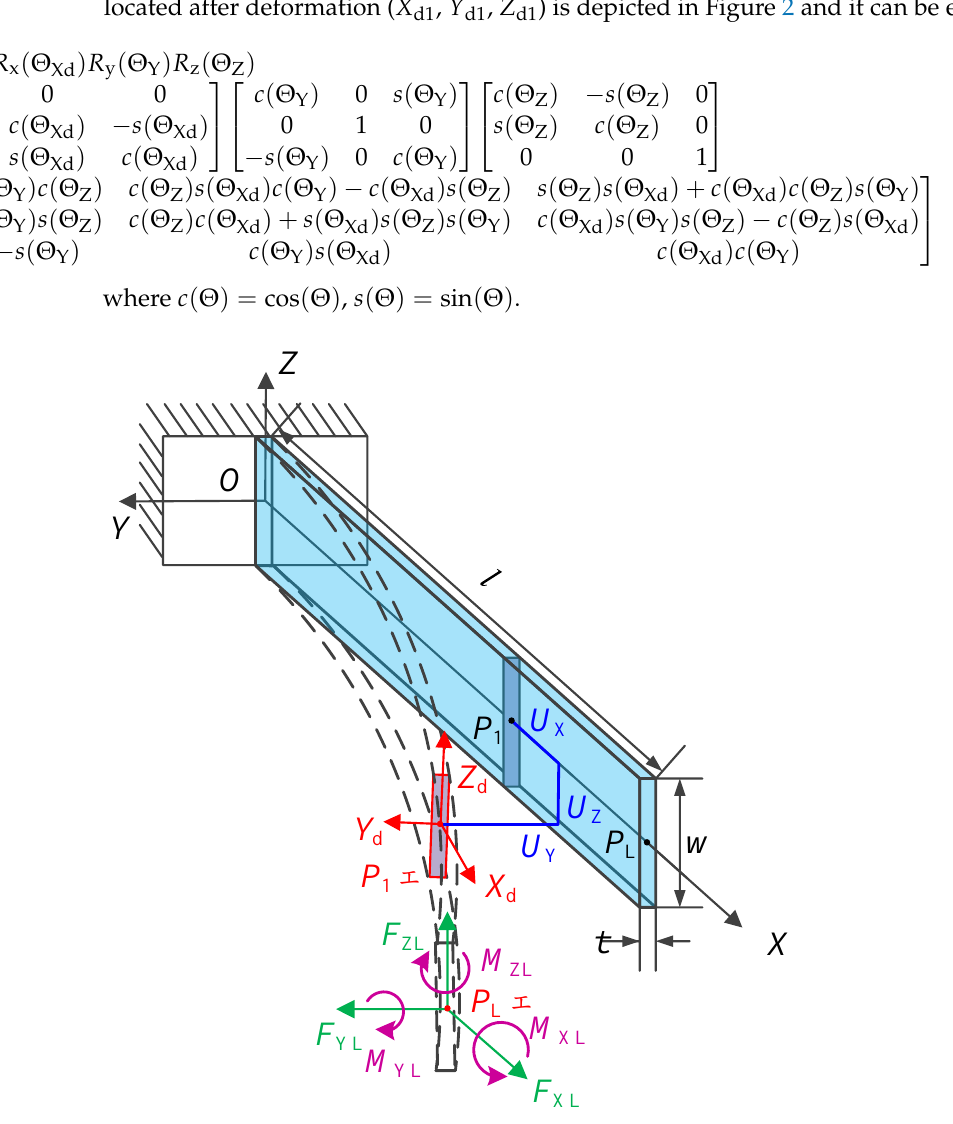
-Θ Y Figure 2. Transformation of the spatial coordinate systems.